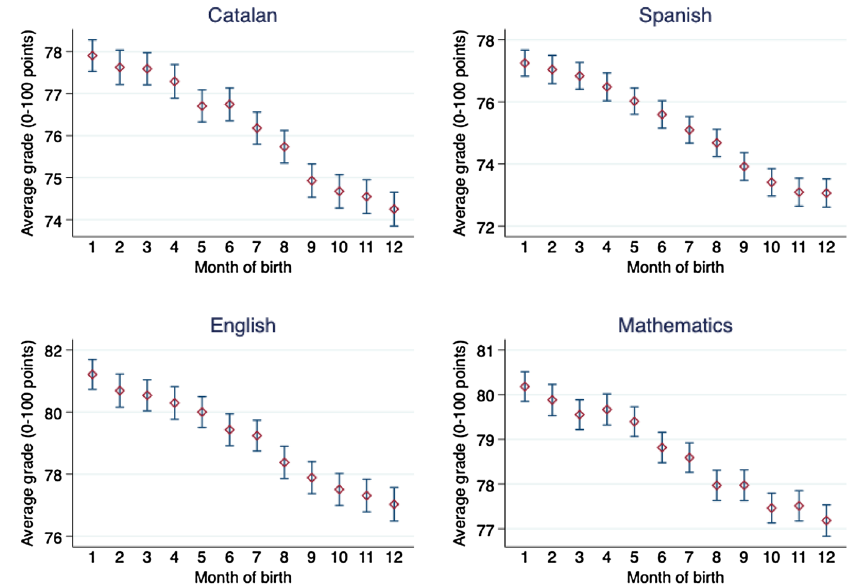
Fig. 4 Average student performance in 2019 tests by month of birth and subject, 2007 cohort. Note : 95% confidence intervals in